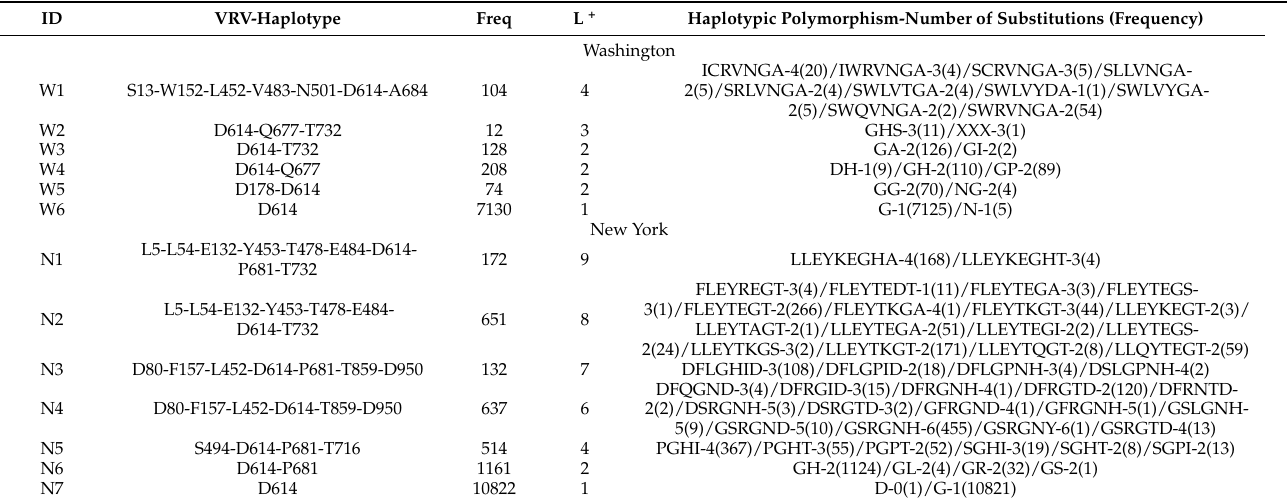
Figure 2. Heatmap showing the presence of 10 selected VRVs among 9147 cases in Washington state. Unsupervised learning was used to organize the 10 VRVs into 5 residue groups (RG1 through RG5) and to organize the 9877 cases into 12 patient groups (PG1 through PG12). Table 2. VRV-haplotypes identified in Washington and in New York: state-specific frequencies of cases, number of VRVs per VRV-haplotype, and haplotypic polymorphisms (state-specific frequencies). Unimputable residues are denoted with an